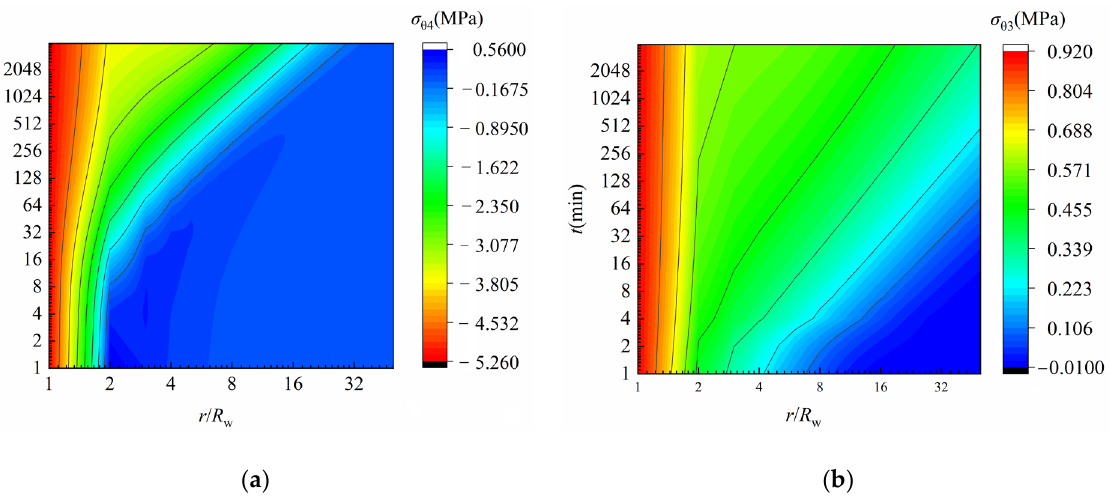
Figure 4. Rock stress changes caused by formation temperature and pore pressure (Q = 0.5 m 3 /min). ( a ) Formation temperature; ( b ) pore pressure.